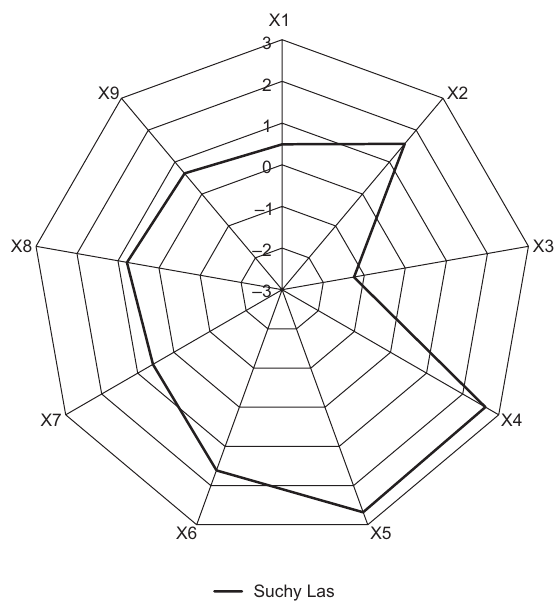
Fig. 1. distribution of the values of normalised indicators in the commune of Suchy las, which has the best determi- nants of the quality of life in the Poznań agglomeration. Source: own